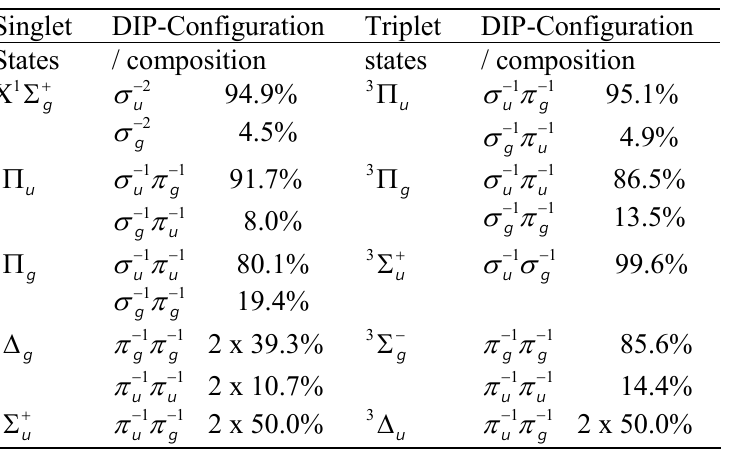
Table IV. Dominant configurations for ground and excited states of F obtained from DIP-STEOM calculations in cc-pVTZ basis.